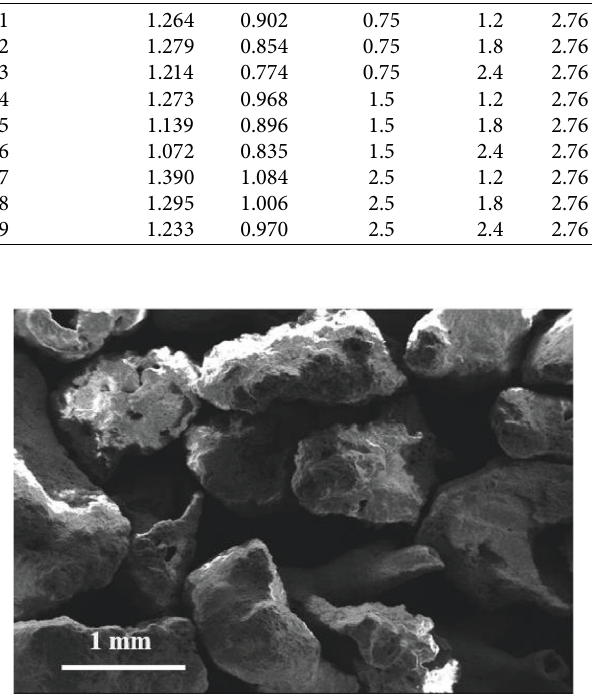
Figure 2: Scanning electron microscopy of calcareous